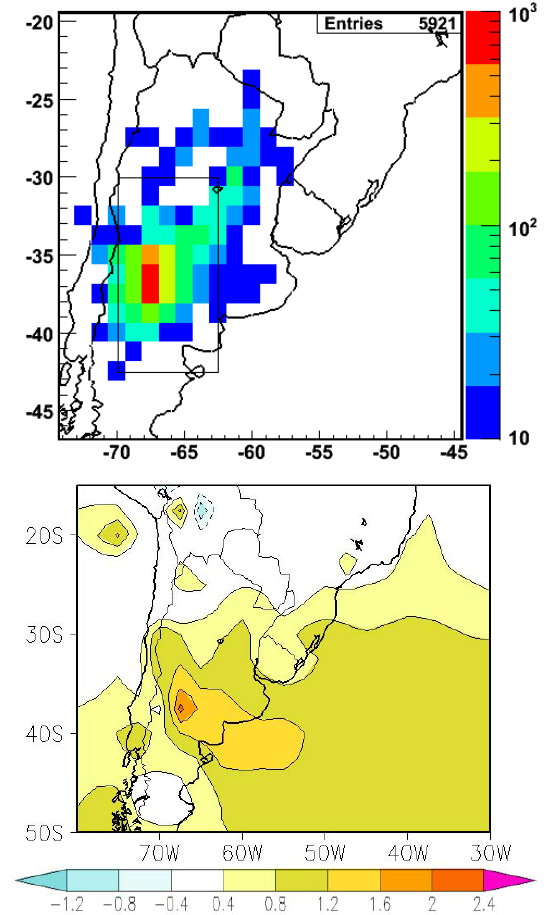
Fig. 5. Top: 2-D-Histogram of the occurrences of the AC with the LPT detected by our algorithm in the studied period. The number of events in each grid box is shown in a color-log scale. Lower: climatology of frontogenesis by deformation in equivalent potential temperature at 850hPa. Color scale is in K / 100km /